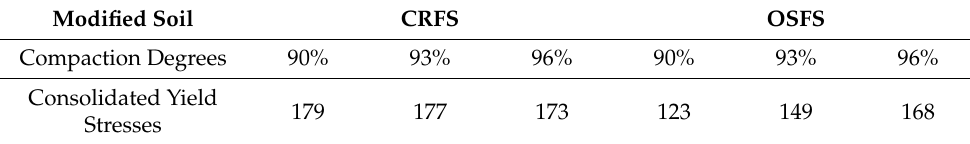
Table 7. Consolidation yield stress of modified soil with different compaction degrees (kPa).